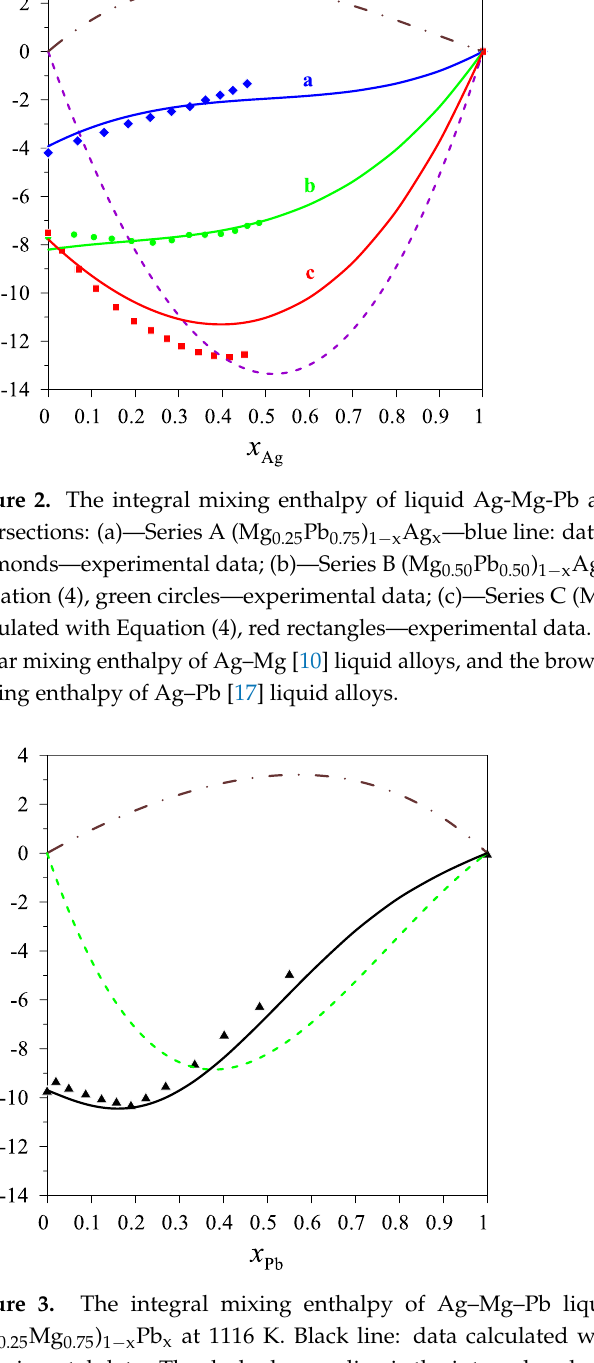
Table 5. The partial and integral functions of Ag – Mg – Pb liquid alloys.